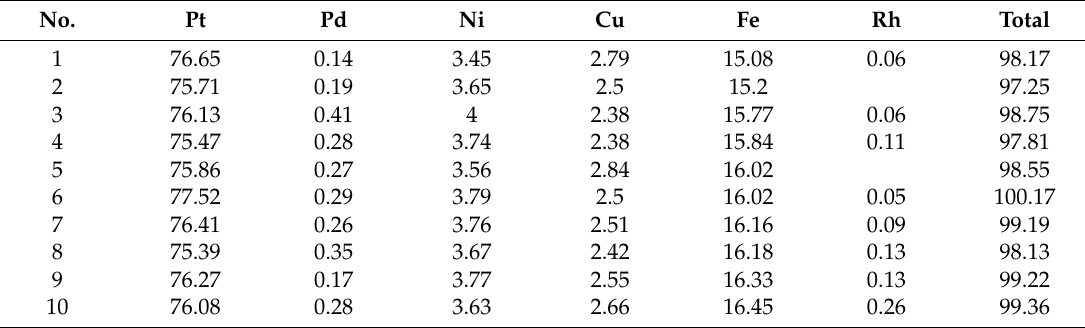
Table 8. Composition of tetraferroplatinum in the Southern 2 orebody, wt %.